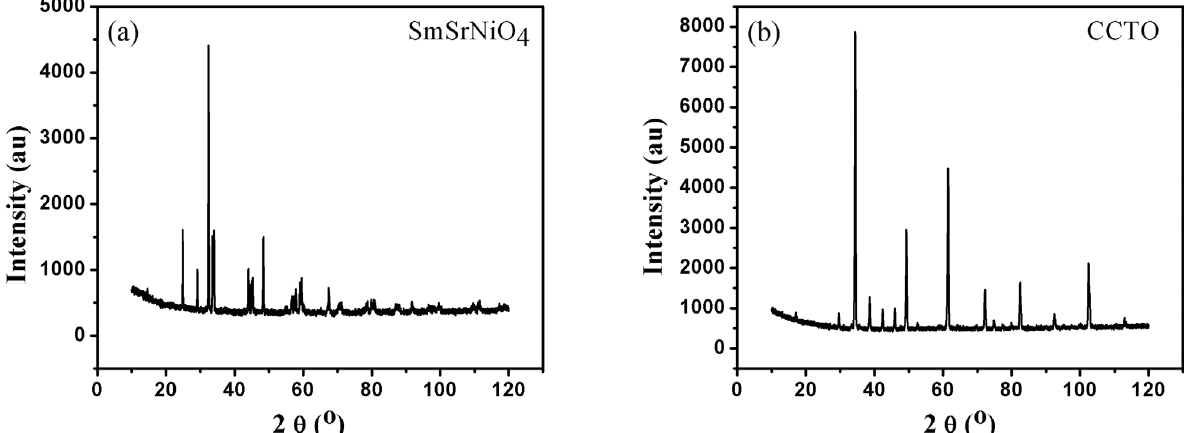
Sr NiO and ( b ) CCTO 1.5 0.5 4